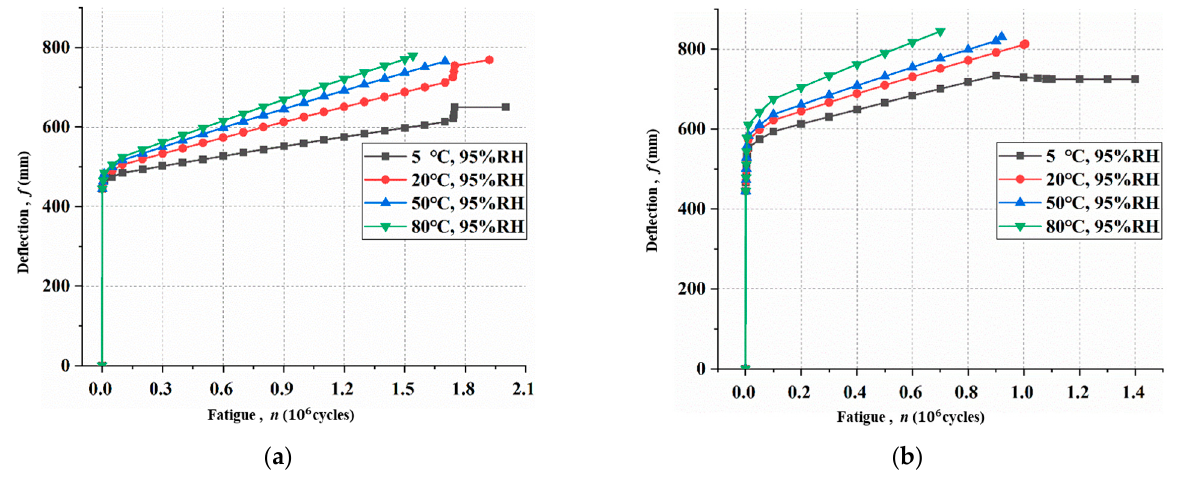
Figure 7. The tensile stress of CFRP under different hygrothermal environments at different loading levels: ( a ) 27.5 kN; ( b ) 30.0 kN.